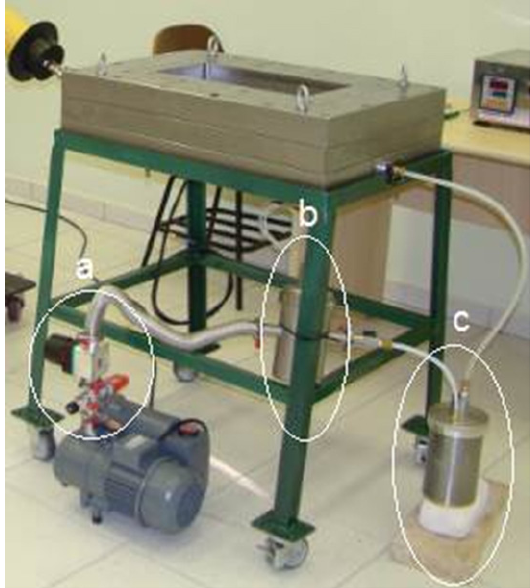
Figure 4. Controlled vacuum system: a - manometer; b - monomers cooled trap; c - resin